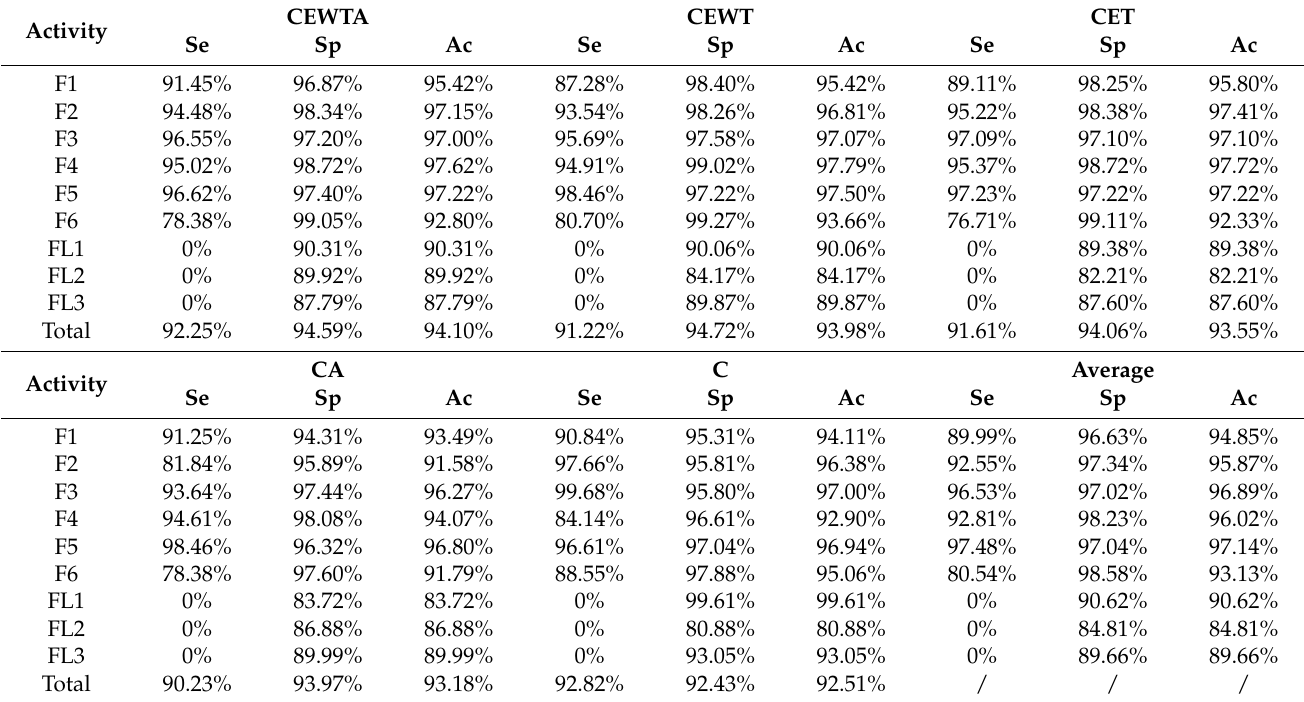
Table 5. Detection efficiency for each fall activity.